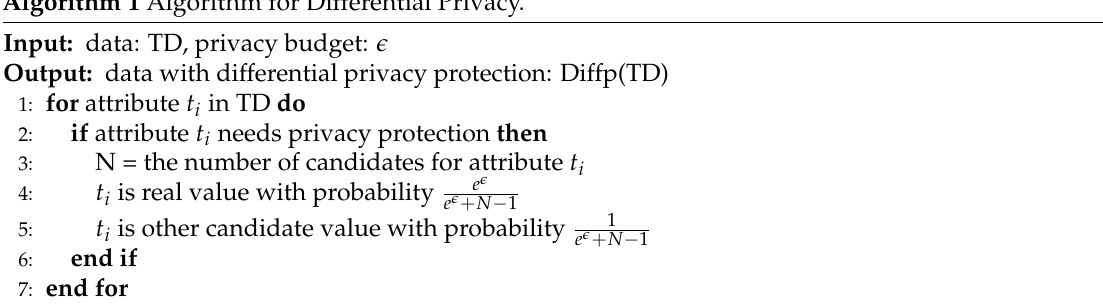
Algorithm 1 Algorithm for Differential